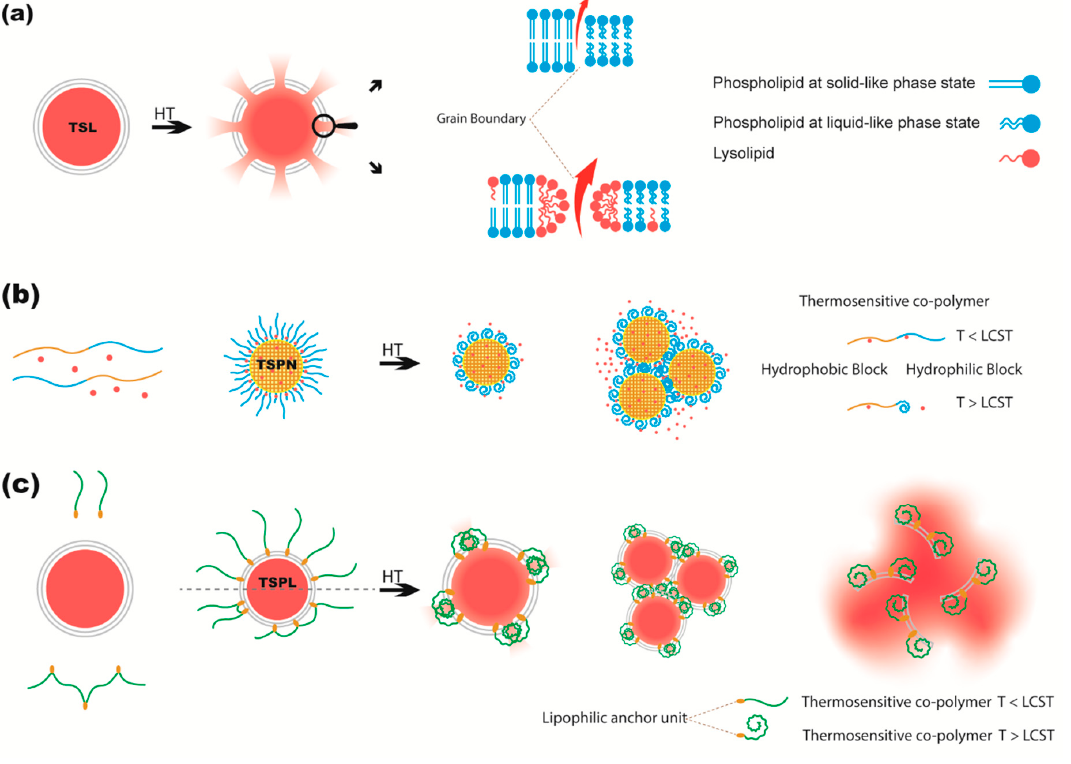
Figure 2. Schematic representation of postulated mechanisms of drug release from di ff erent temperature sensitive nanoparticles in response to exposure to hyperthermia (HT). ( a ) Upon heating of a temperature sensitive liposome (TSL) phospholipids grain boundaries form between coexisting phospholipids of solid-like and liquid-like states from which encapsulated drug releases. Presence of lysolipids stabilizes the grain boundaries leading to ultrafast drug release from the liposome at hyperthermia condition. ( b ) At temperatures (T) below the release temperature (lower critical solution temperature, LCST) of temperature sensitive copolymers, from which temperature sensitive polymeric nanoparticles (TSPN) have been formed, the outer shell of the nanoparticle consists of fully hydrated and stretched polymers. By increasing the temperature higher, the hydrated outer shell collapses by losing hydrophilicity and becomes hydrophobic which leads to drug release and aggregation of TSPN. ( c ) Upon heating of liposomes modified with temperature sensitive polymers (TSPL) to temperatures above the LCST, the temperature sensitive motifs of copolymers lose hydrophilic reactions and tend to interact with hydrophobic regions of phospholipid bilayers which results in drug release, aggregation, or disintegration of liposomes.